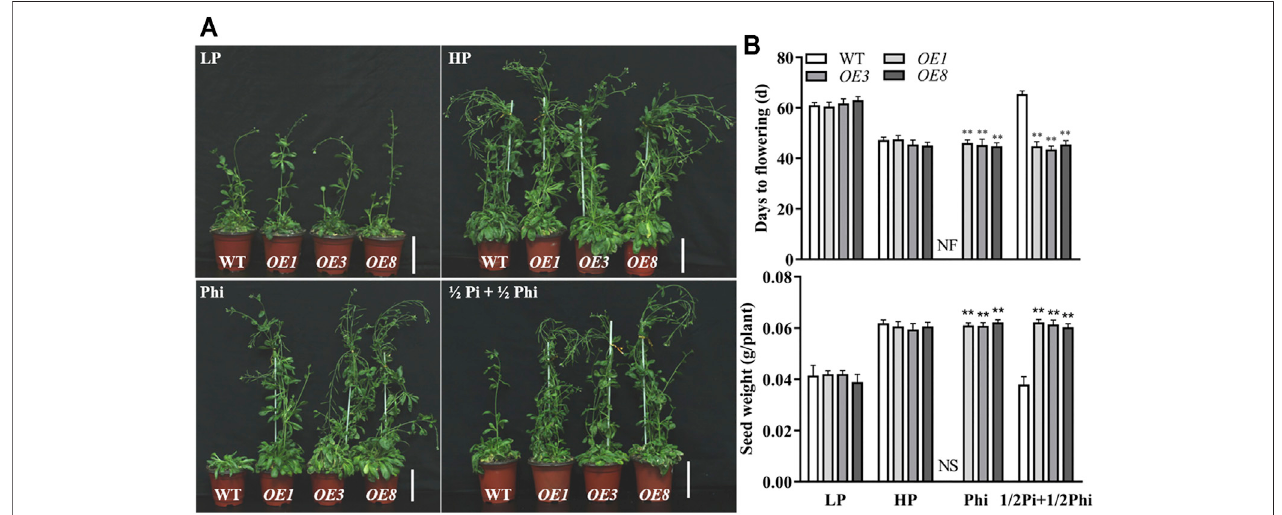
FIGURE 3 | Effect of different phosphate- and phosphite-based nutrition on fl owering time and yield in WT and ptxD Q transgenic Arabidopsis . (A) Phenotypes of WT ( Col-0 ) and transgenic ( OE3 , OE5 , and OE8 ) plants at seed setting stage under different phosphorus nutrition conditions. Scale bar (cid:2) 2 cm. (B) Days for fl owering timeandseedyieldofWTandtransgenicplants.TransgenicandWT Arabidopsis weregrowninasterilizedmixtureofsphagnumpeatmoss/perlitesoilmixfertilizedwith MSsolutioncontaining5 μ Mphosphate (LP),1.25 mMphosphate(HP),1.25 mMphosphite (Phi),or½Pi+½Phi(625 μ MPi+625 μ MPhi).Thedataareshownas means ± SD for fi ve replicates. Asterisks indicate signi fi cant differences as compared with WT plants (Turkey ’ s test, ** p ≤ 0.01). NF, no fl ower; NS, no seed.